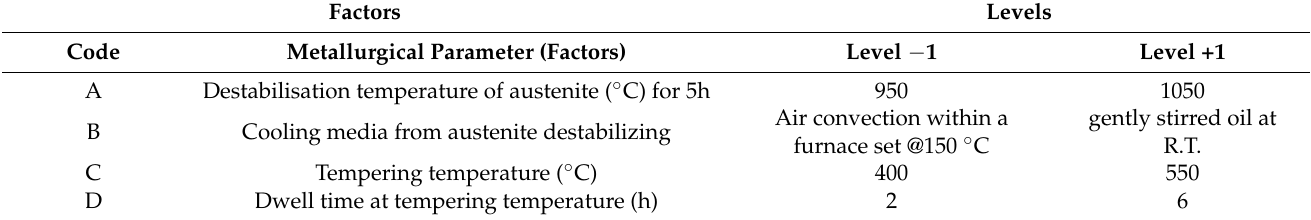
Table 2. Factors and